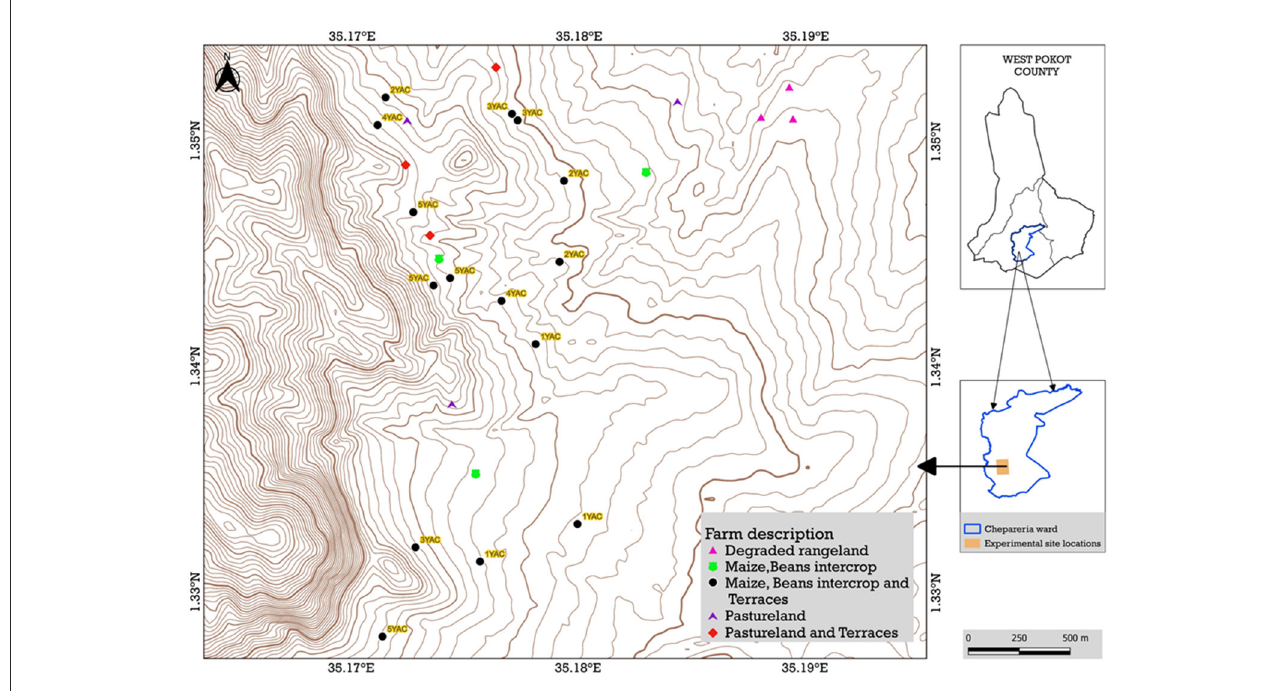
FIGURE1 Location and elevation of Chepareria ward where the study was conducted.